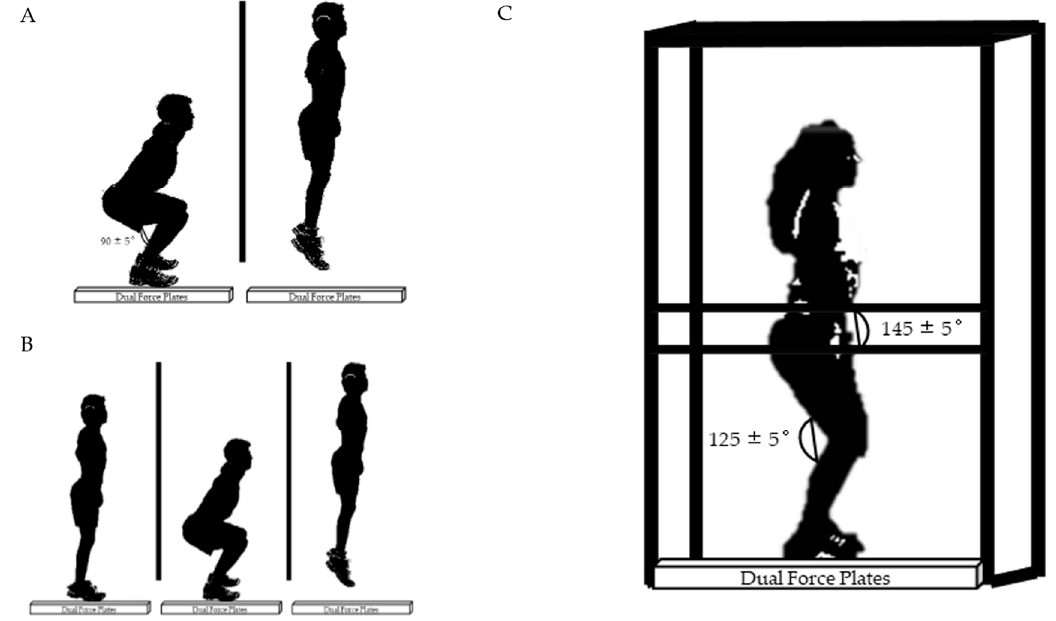
Figure 1. Performance testing. Panel ( A ) depicts the start and flight phase of squat jump testing, panel ( B ) depicts countermovement jump testing, and panel ( C ) depicts the isometric mid-thigh pull positioning.